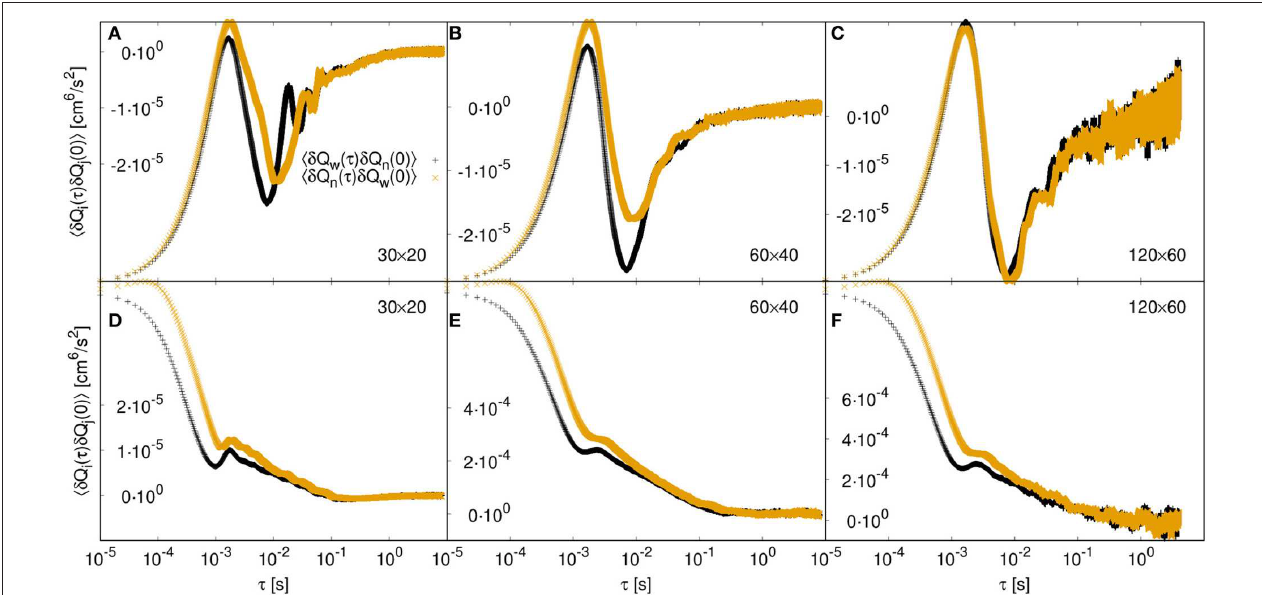
FIGURE 9 | Cross-correlation functions of wetting (Q w ) and non-wetting (Q n ) flows. The upper panels (A–C) show the cross-correlations for case (B) with zero surface tension and increasing network size from (A) to (C) . The lower panels (D–F) show the cross-correlations for case (A) with γ = 30 mN/m. The network size is increasing from left to right from 30 × 20 to 60 × 40 to 120 × 60